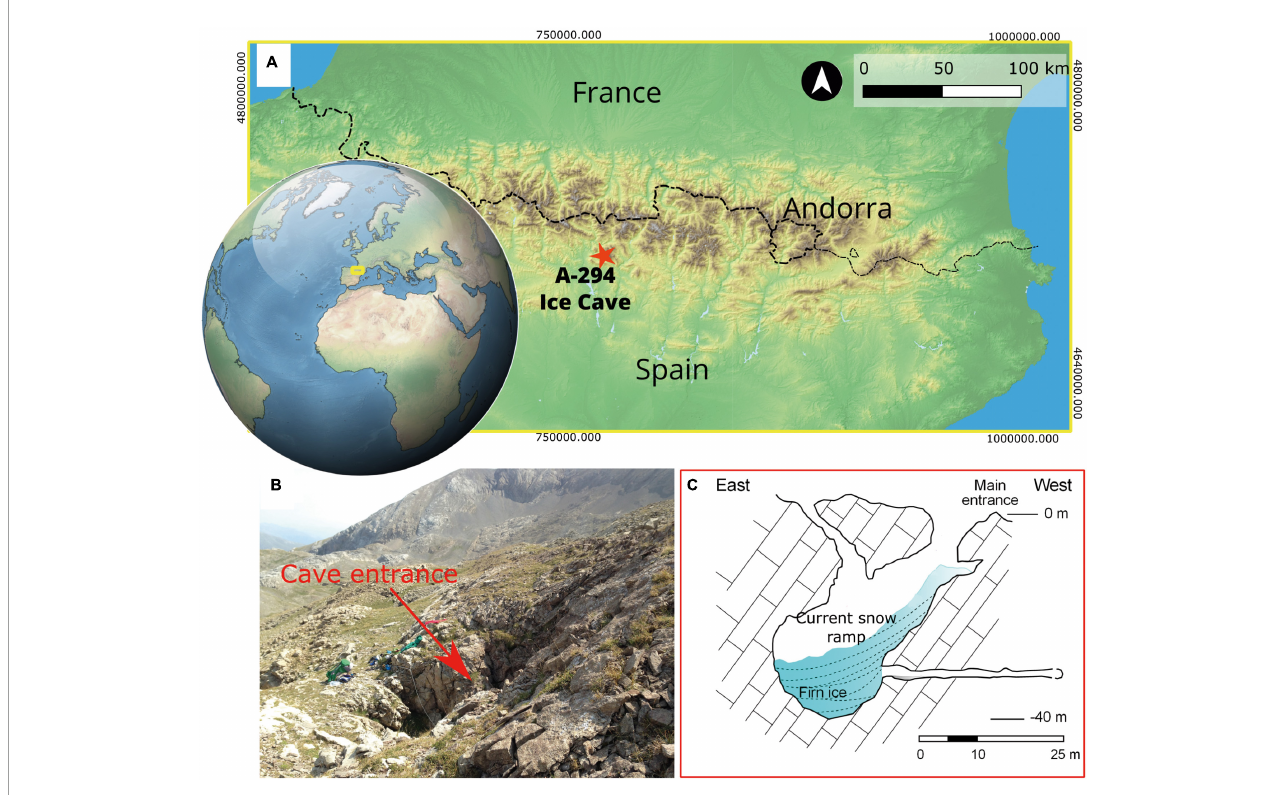
FIGURE1 Geological setting of samples. (A) Location of the A294 ice cave in the Central Pyrenees. (B) Photograph showing the main entrance of the cave. (C) Profile view of the A294 ice cave showing the snow ramp and the position of the ice body, modified from Belmonte-Ribas et al. (2014).